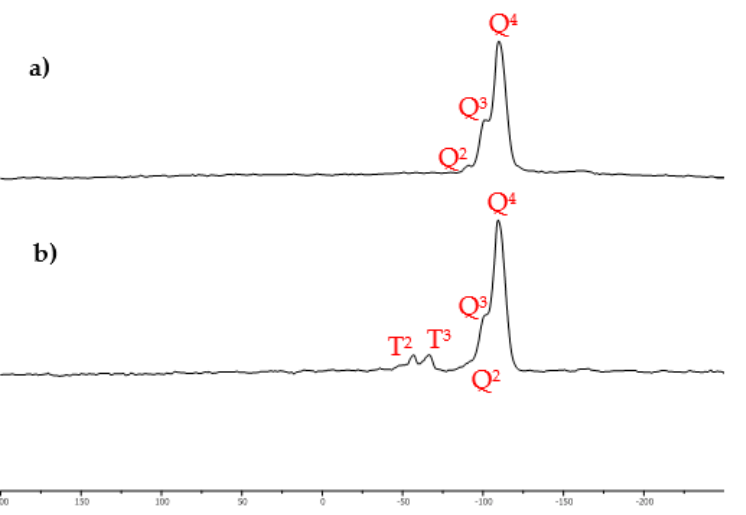
Figure 4. 29 Si NMR spectra of ( a ) pure silica and ( b ) Si-TS-SSIL (modified activated silica gel with [MTMSPI][TS] ionic liquid).